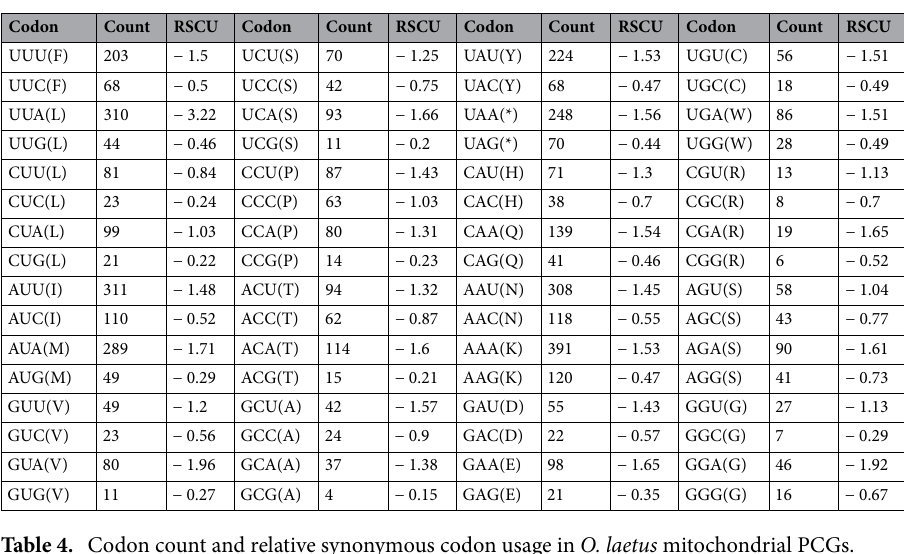
Table 4. Codon count and relative synonymous codon usage in O. laetus mitochondrial PCGs.